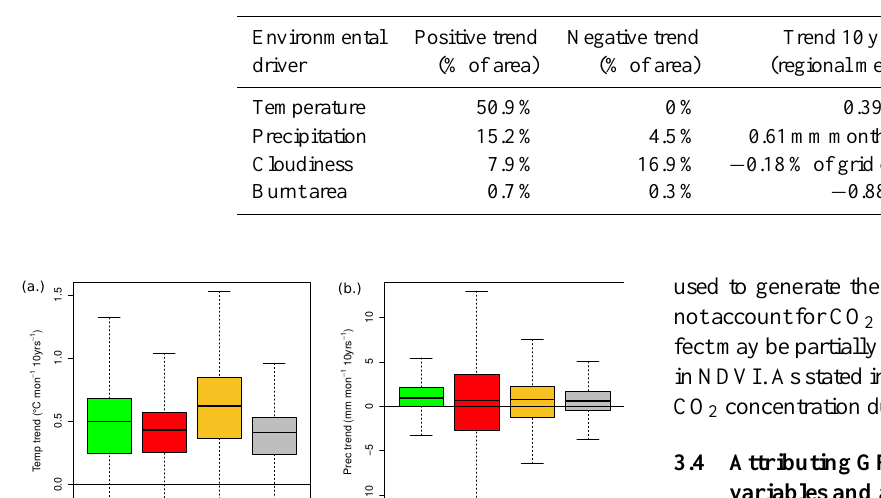
Table 4. Trend statistics for annual monthly averages of environmental variables. The first and second columns list the fraction of the region with significant (95% significance level) positive trends and negative trends respectively. The third column is the regional mean trend of the variables per decade. The fourth column is the coefficient of variation, estimated as the distribution mean divided by the standard deviation.